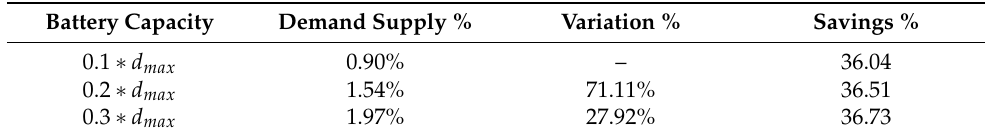
Table 2. Impact of battery